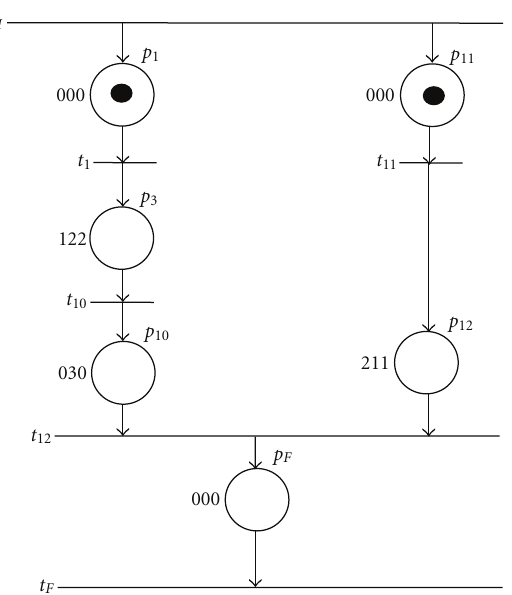
Figure 6: Resulting net with a Type-II